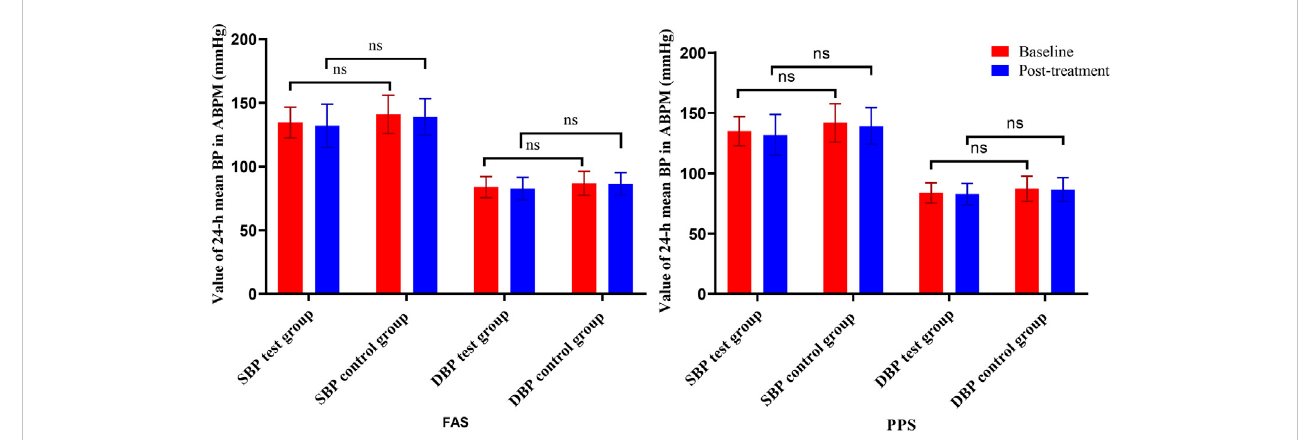
FIGURE 4 Changes in the 24-h mean BP from ABPM (left is FAS; right is PPS). Note: ns = non-signi fi